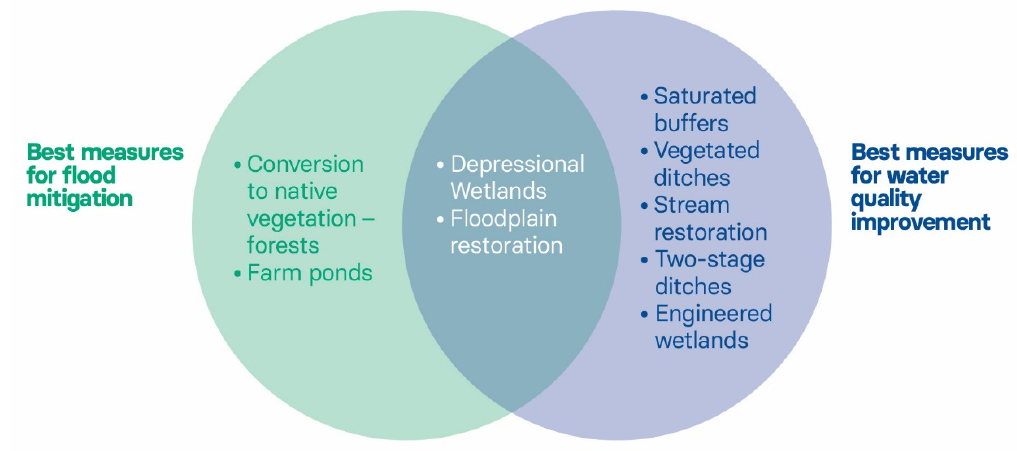
Figure 4. NI measures most promising for both flood mitigation and water quality improvement are shown in the middle. Measures most promising for flood mitigation only are on the left and measures for water quality improvement only are on the